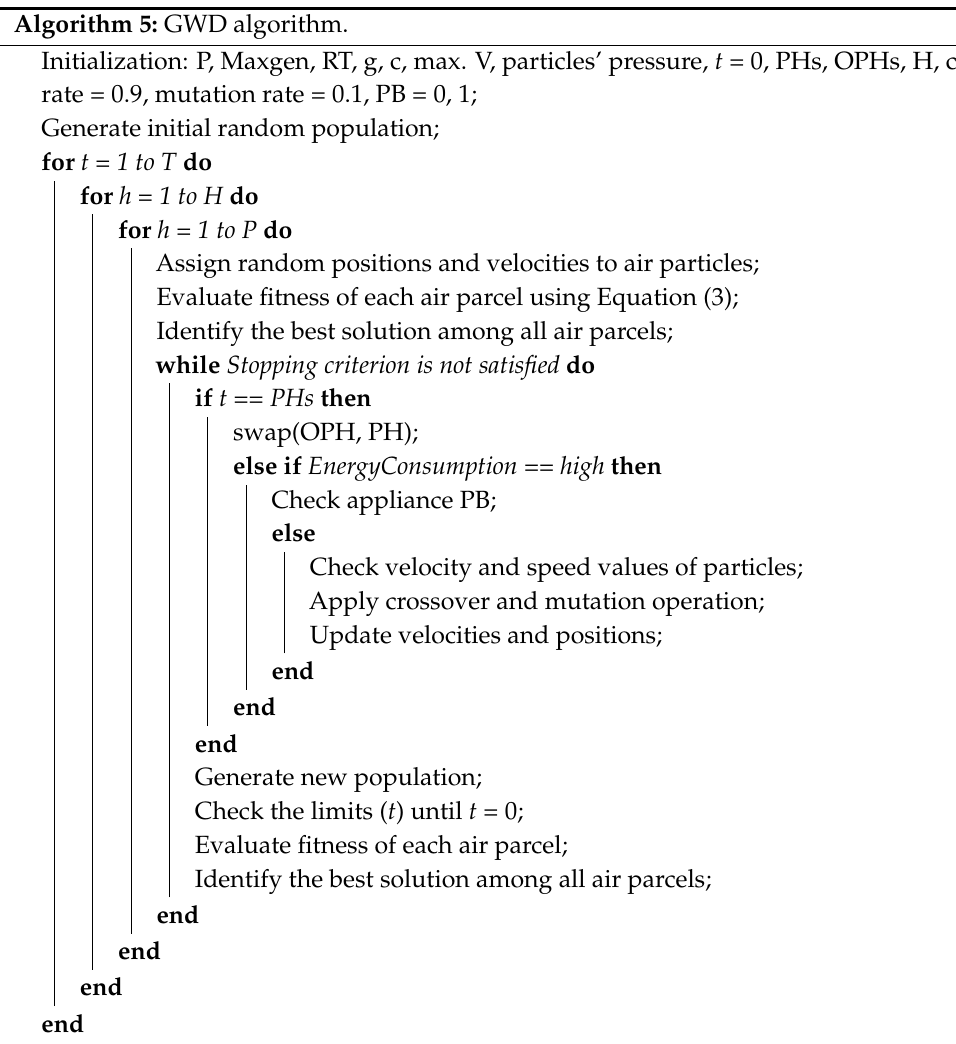
Algorithm 5: GWD